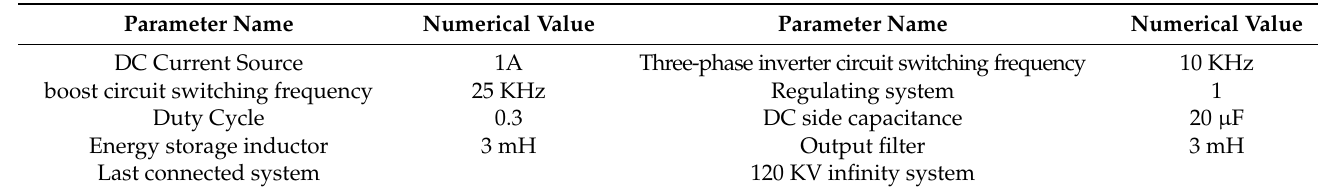
Figure 5. Photovoltaic grid-connected inverter model. Table 4. Individual parameters of the PV grid-connected inverter model.